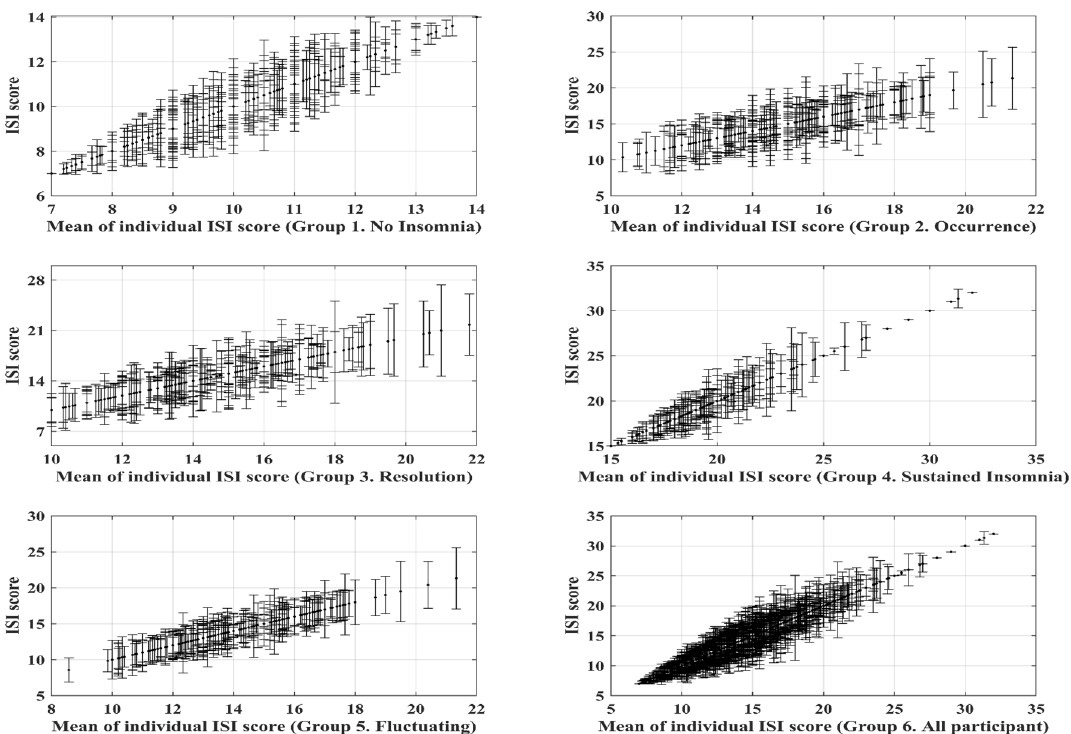
Figure 2. Variability of Insomnia Severity Index scores in each group. The x -axis indicates individual means, and the vertical lines indicate individual standard deviation of Insomnia Severity Index scores. ISI Insomnia Severity